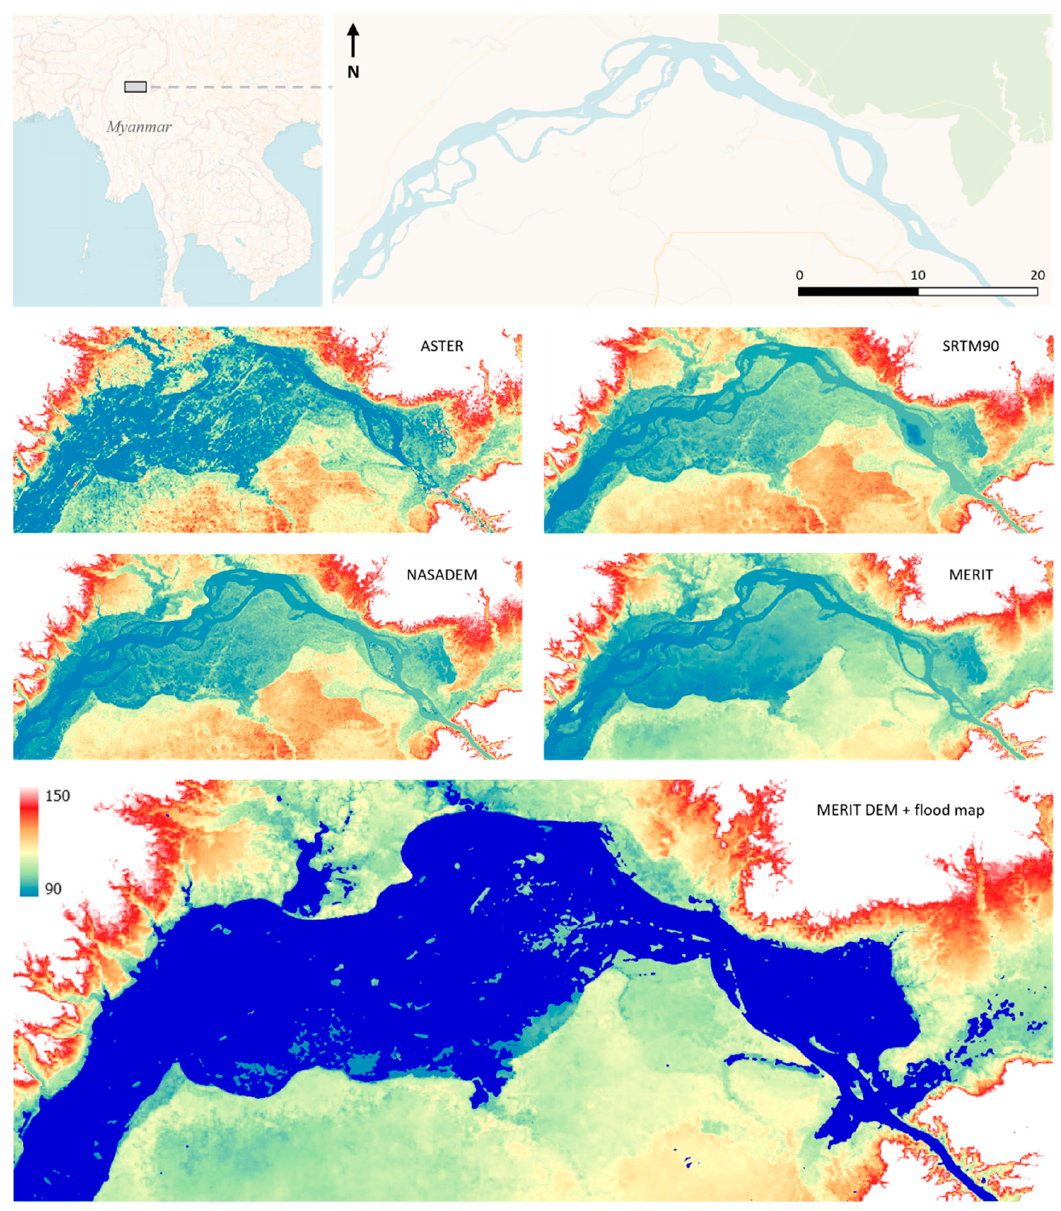
Figure 7. Region of interest for remote sensing case study; upstream Irrawaddy River in Myanmar (river flow is from east/right to west/left), including the four DEMs used for this case study and a flood map derived from Sentinel-1 imagery of 16 July 2019, overlaid on the MERIT DEM.